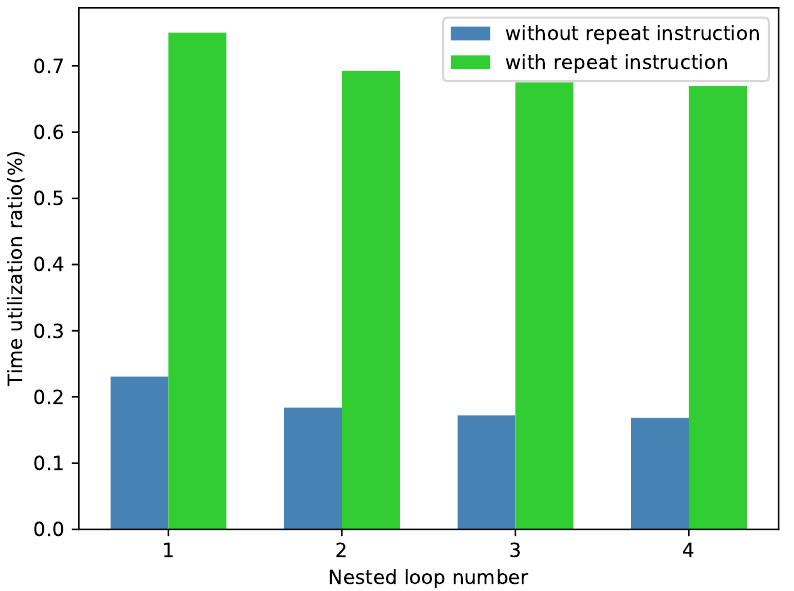
Figure 5. The time utilization ratio comparison between the code with/without repeat